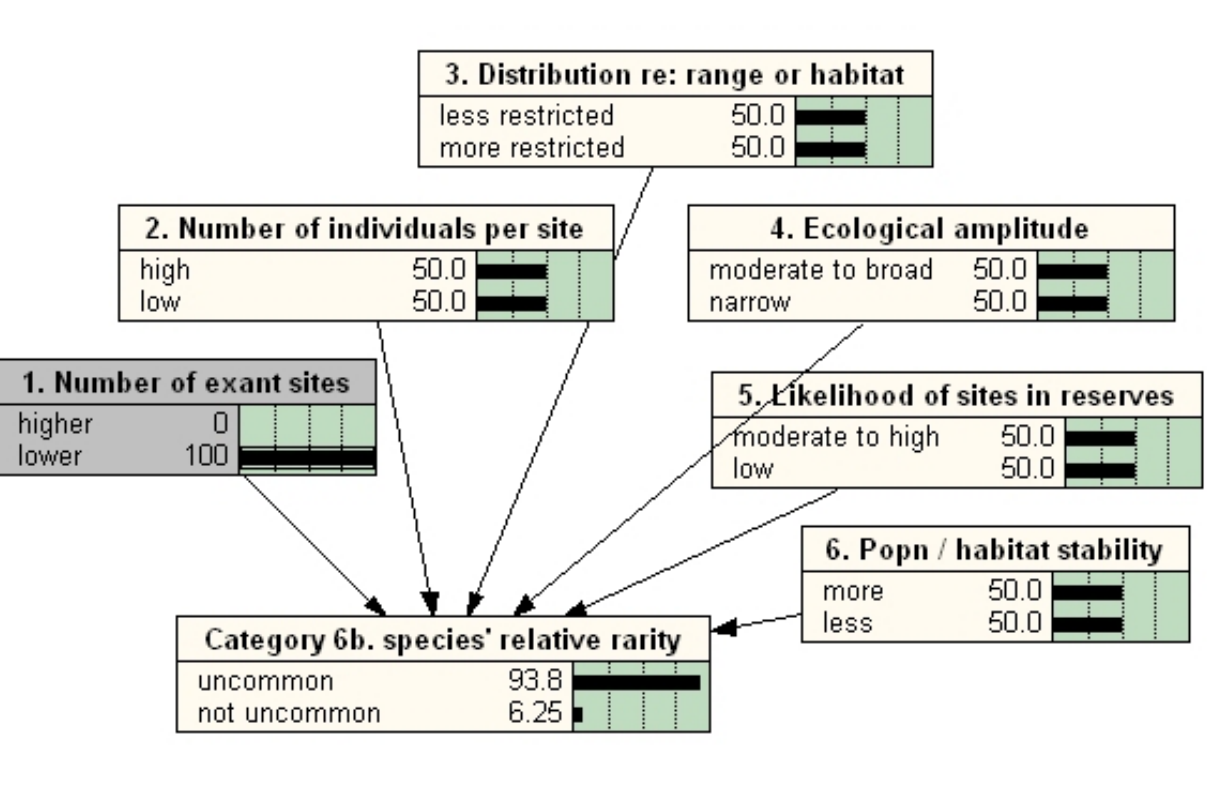
Fig. 8. Bayesian belief network (BBN) submodel for determining part of evaluation category 6, species relative uncommonness. See Table 2 for Record of Decision guidelines used to develop this